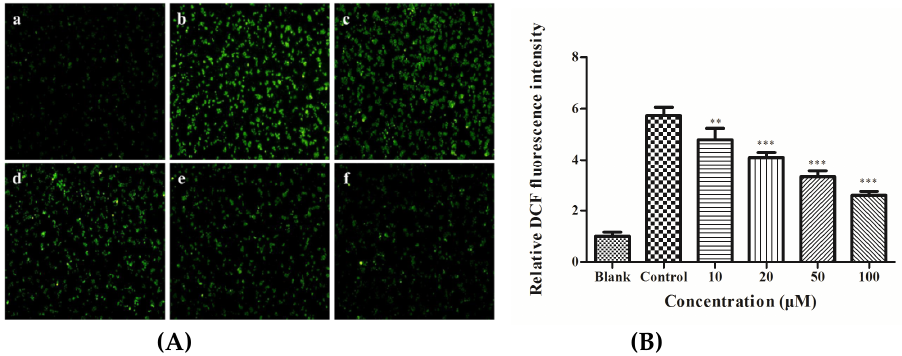
Figure 2. Effect of YGDEY on the intracellular reactive oxygen species (ROS) level. ( A ) HepG2 cells were pretreated with YGDEY for 24 h before treatment with 0.75 M ethanol for 2 h. Then, the cells were exposed to DCFH-DA for 20 min. DCF fluorescence of the treated cells was measured by using an inverted fluorescence microscope. (a) HepG2 cells without treatment (the blank group); (b) cells exposed to 0.75 M ethanol (the control group); (c, d, e, and f) cells pretreated with YGDEY (10, 20, 50, and 100 μM, respectively) prior to treatment with 0.75 M ethanol. ( B ) The relative DCF fluorescence intensity. Data are shown as means ± SD ( n = 3). ** compared with the control group, p < 0.01. *** compared with the control group, p < 0.001.